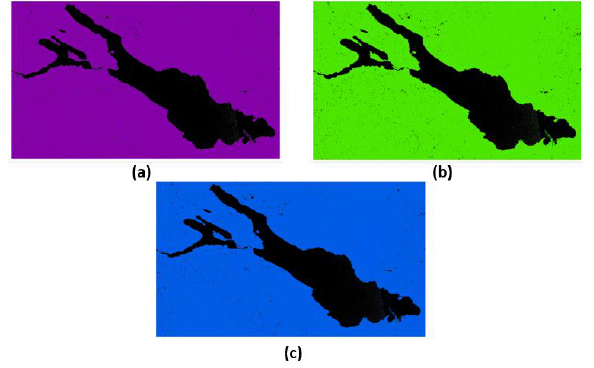
Figure 9. Segmentation results (a) Using Mean-Shift segmentation results, (b) Using Random Forest segmentation results, (c) Using Whale Optimization segmentation results